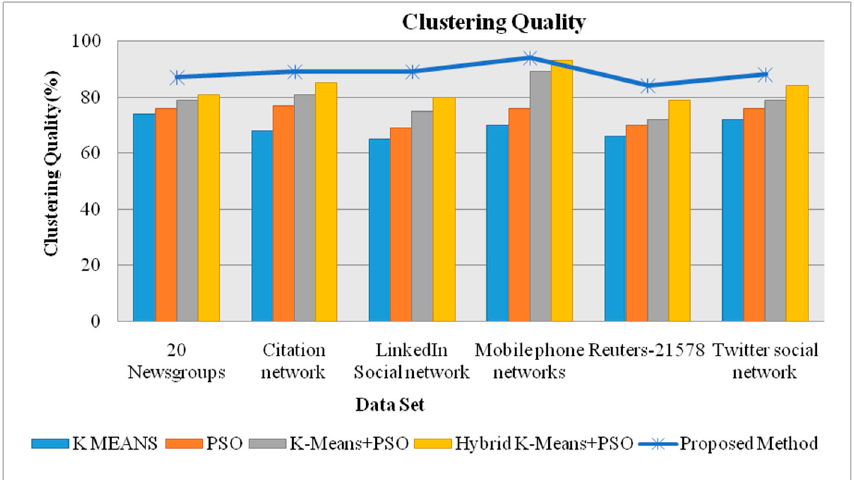
Figure 3. Clustering and analyzing quality comparison.